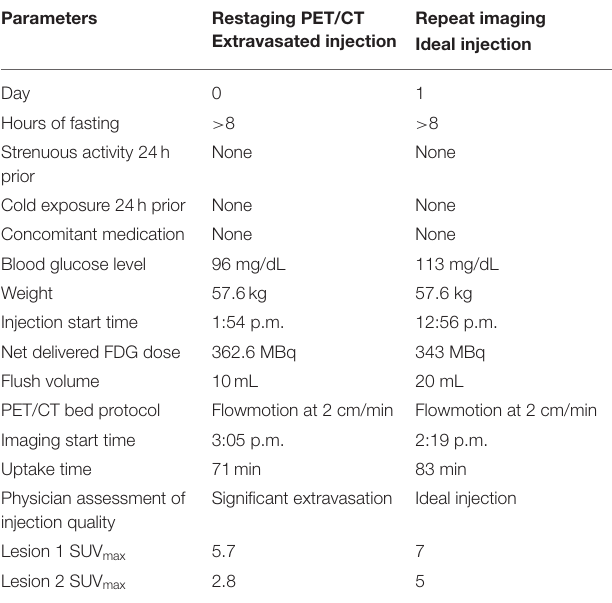
TABLE 6 | Procedure parameters for Patient D. Parameters